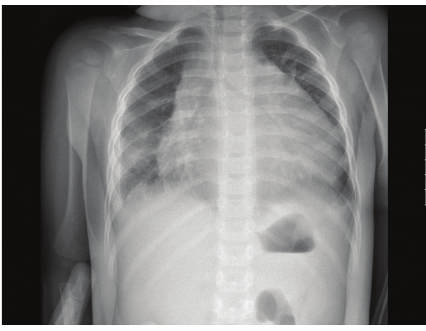
Figure 2: Chest X-ray. Increase of the cardiothoracic index at the time of diagnosis of cardiac tamponade. The patient had a normal chest X-ray 10 days